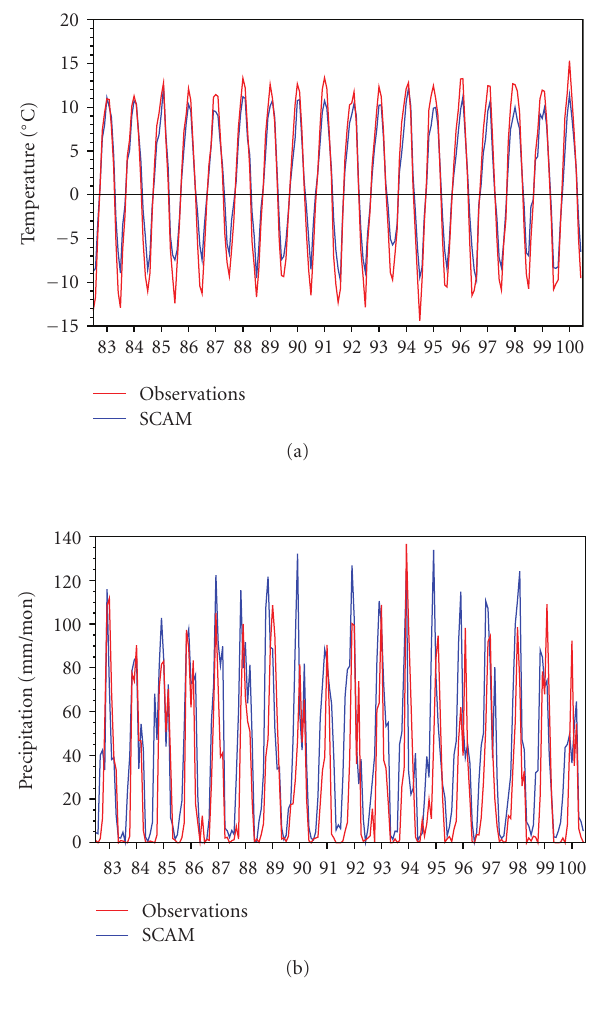
Figure 4: Comparison of SCAM simulations (blue line) and observations (red line) at the Xinghai station: (a) Precipitation; (b) temperature.